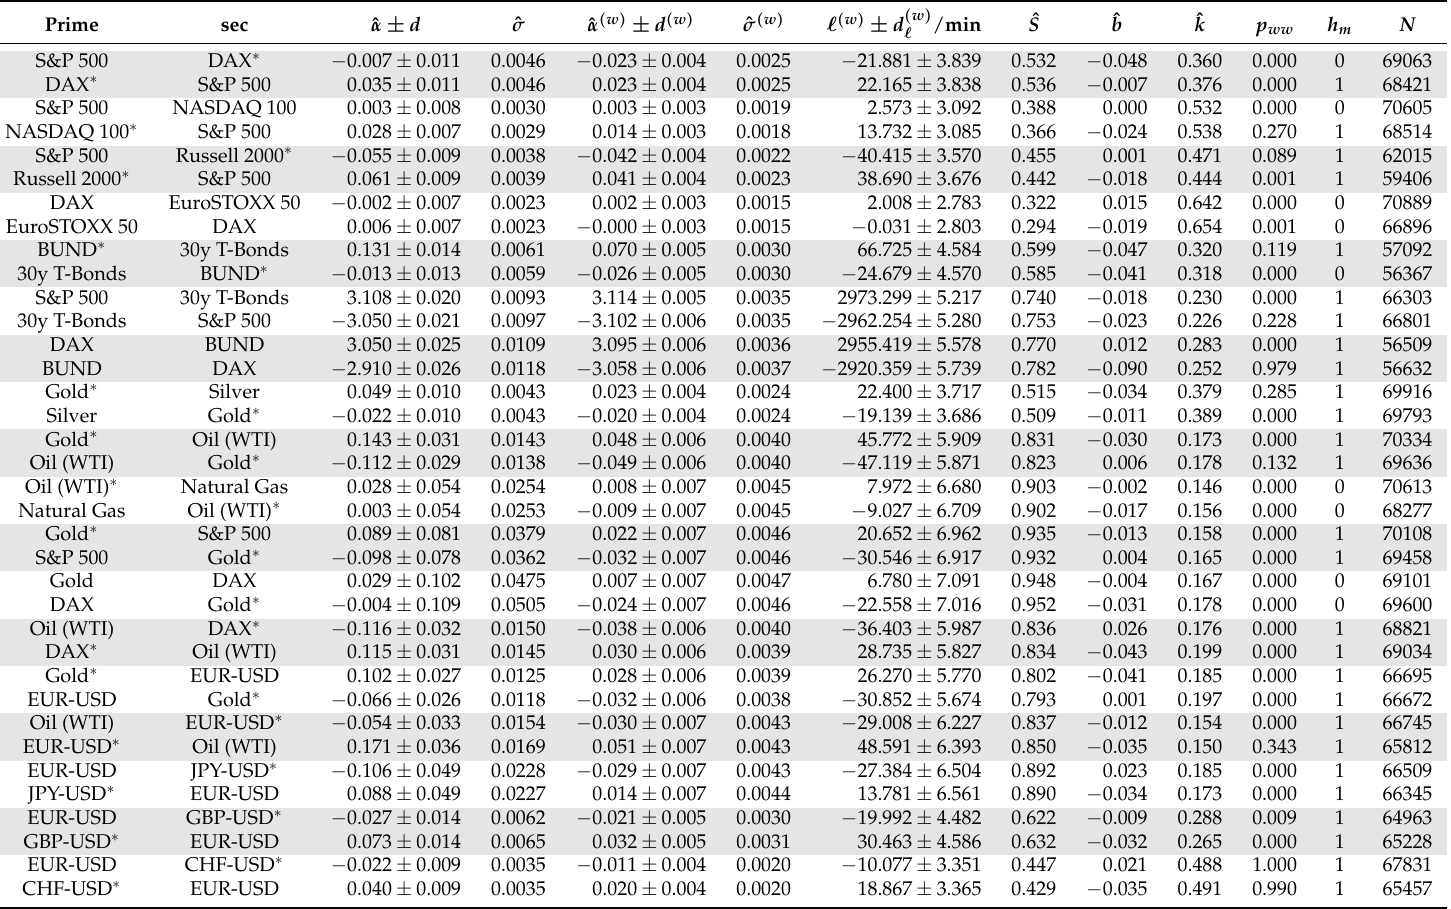
Table 3. Results on 10min chart (time of extrema confirmed). ∗ This market leads the other